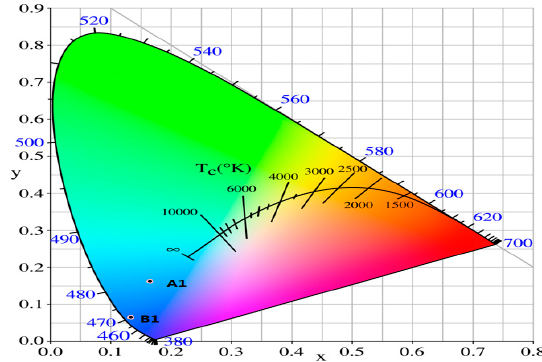
Figure 6. The color coordinates of A1 and B1 .